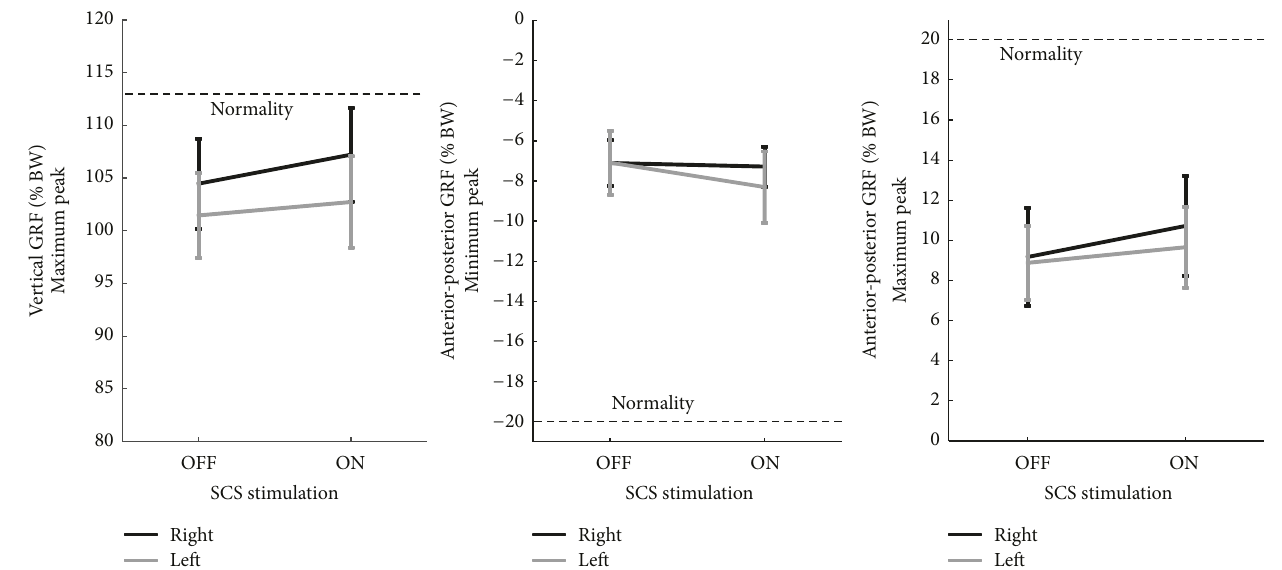
Figure 2: Changes in GRF peak values on both sides under ON and OFF